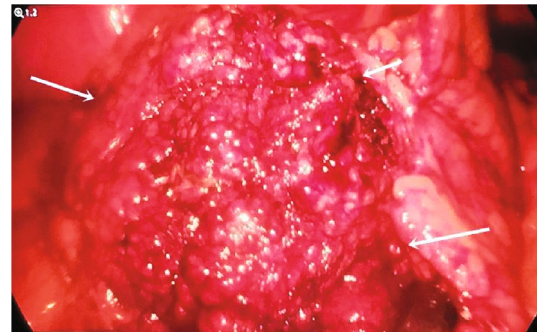
Figure 3: Omental mass dissection.